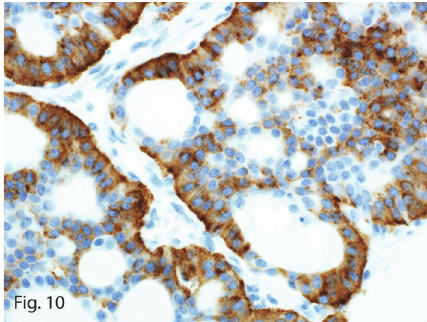
Figure10:Synaptophysinimmunoexpressioninthetumor(original magnification × 40).